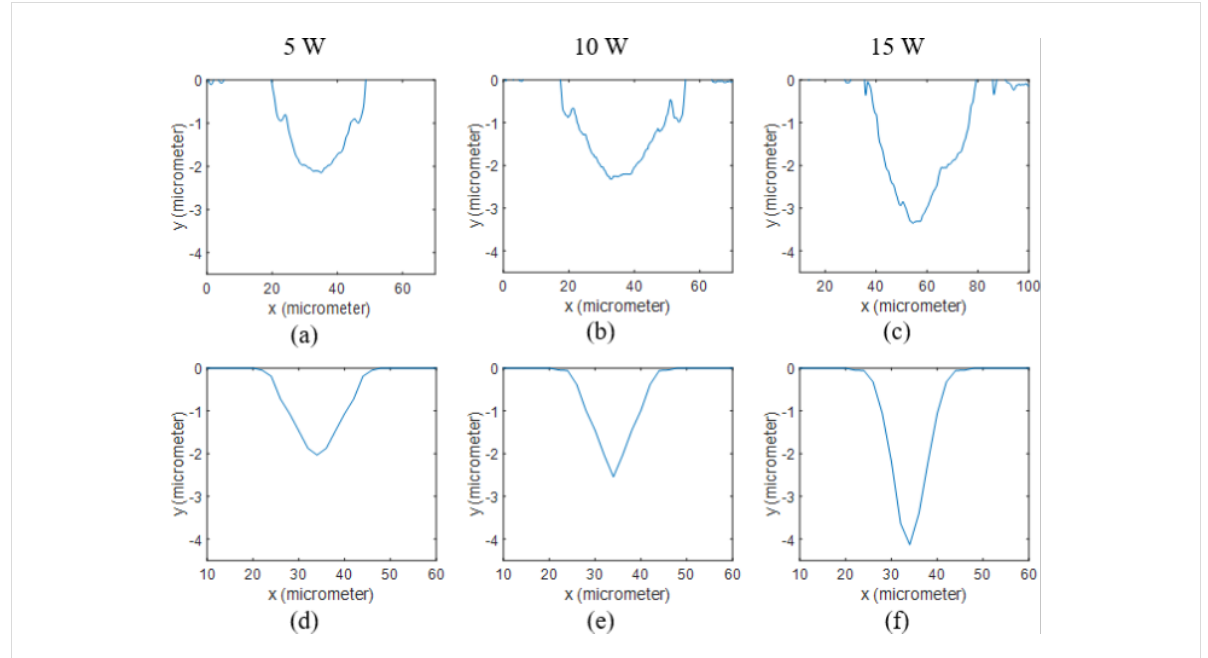
Figure 5: 2D profiles of Al coated Si samples processed at 50 kHz. Results obtained from measurements when using (a) 5 W, (b) 10 W and (c) 15 W are compared to the ones calculated through the numerical model at (d) 5 W, (e) 10 W and (f) 15 W.